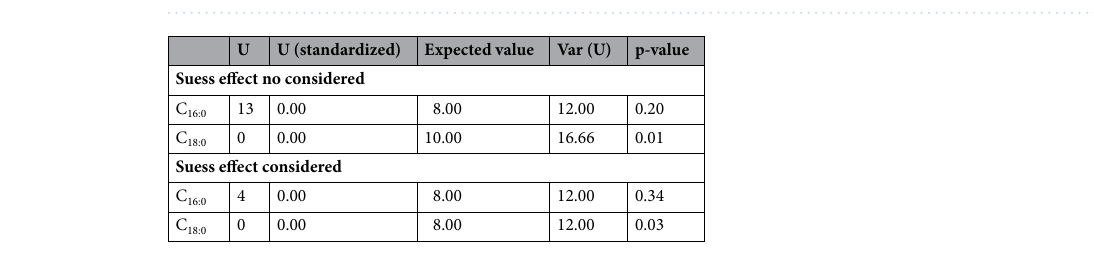
Table 5. Results of a non-parametric test (Mann Whitney, α = 0.05), applied to δ 13 C values on AX1, AX2, AX3 and CS DD and LS samples. H 0 is assumed when p-value >